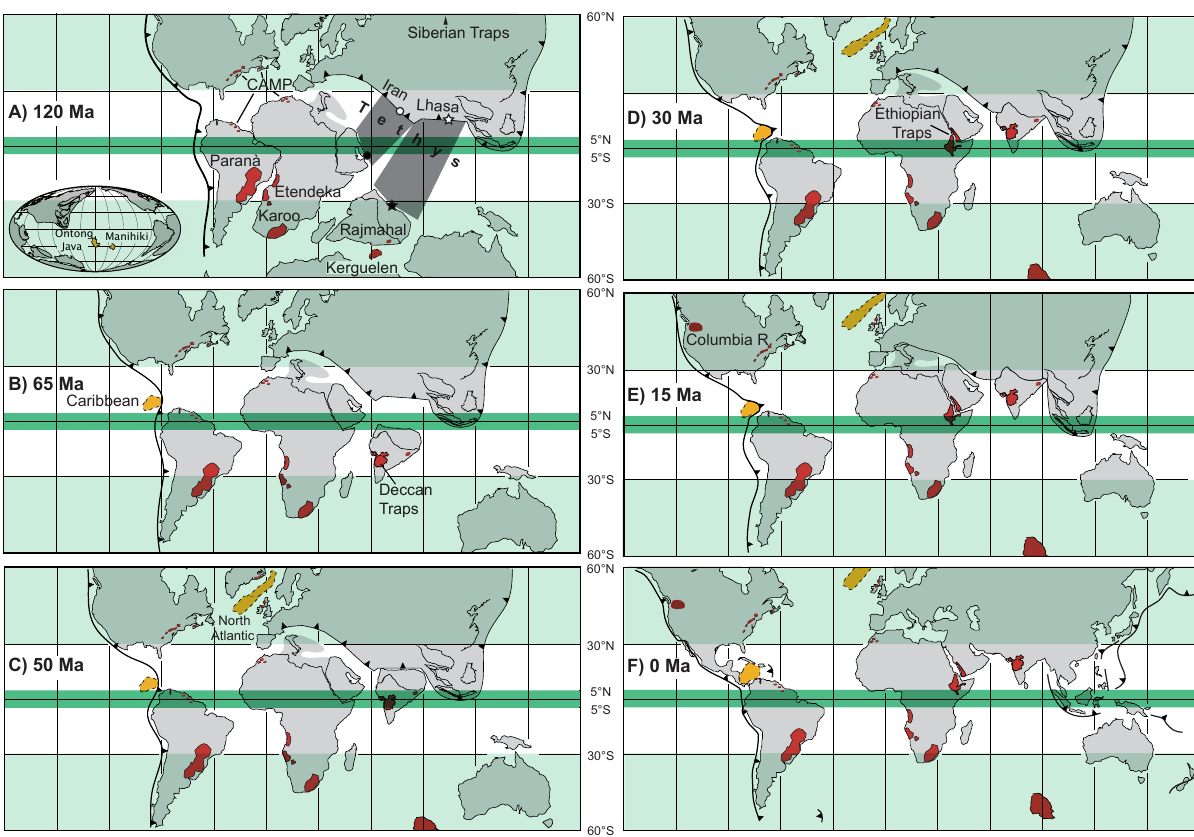
Fig. 3. Paleogeographic reconstructions based on a composite APWP (Table 1, Fig. 2), the finite rotation poles given by Besse and Cour- tillot (2002) from Muller and Roest (1992), Muller et al. (1993), and Srivastava and Tapscott (1986) for the major continents and the rotation poles of Replumaz and Tapponnier (2003) for SE Asian blocks, as discussed in text. (A) 120Ma at about Magnetic Anomaly M0; (B) 65Ma at about Anomaly 29; (C) 50Ma at about Anomaly 21; (D) 30Ma at about Anomaly 11; (E) 15Ma at about Anomaly 5B; (F) present-day geography. The equatorial humid belt ( P >E : precipitation > evaporation) between 5 ◦ S and 5 ◦ N is represented by darker green shading, the temperate humid belts ( P >E ) from 30 ◦ to beyond the latitudinal limits (60 ◦ ) of our paleogeographic reconstructions are represented by lighter green shading, with the intervening arid belts ( P <E ) unshaded, all based on general circulation climate model with idealized geography by Manabe and Bryan (1985). Large continental basaltic provinces are shown in red, large submarine provinces in orange. Paleo- geographic maps were made with PaleoMac software (Cogn´e,